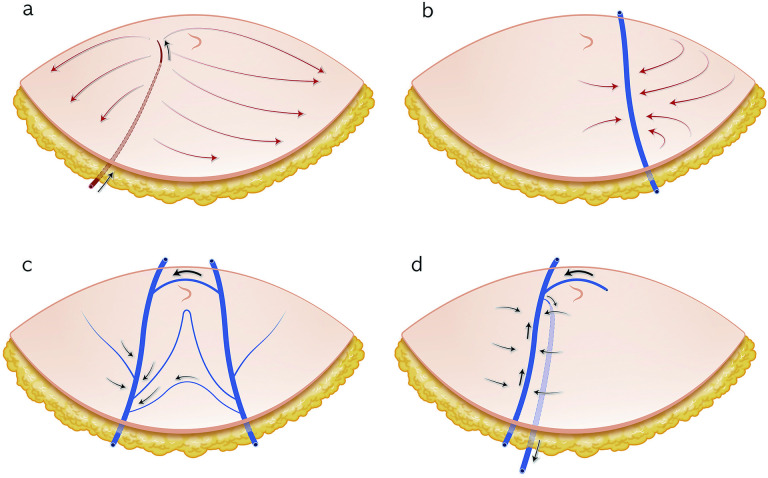
Schematic illustration of the blood flow of the entire deep inferior epigastric perforator flap.(a) Arterial inflow proceeds through the perforator artery. (b) Contralateral venous flow proceeds mainly through the superficial inferior epigastric vein. (c) Midline crossing proceeds through the supraumbilical and infraumbilical midline and gathers in the ipsilateral superficial inferior epigastric vein. (d) Venous outflow proceeds through the vena comitantes of the perforator artery.